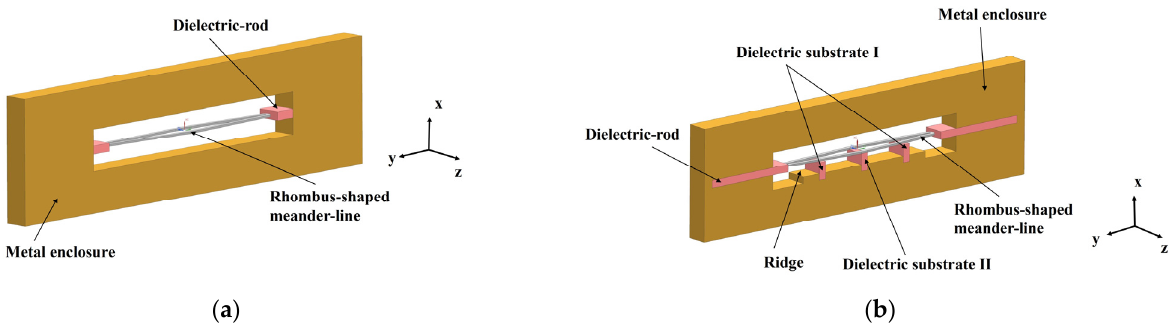
Figure 1. Single period of ( a ) DS-RSML SWS and ( b ) MDSRL-RSML SWS models.